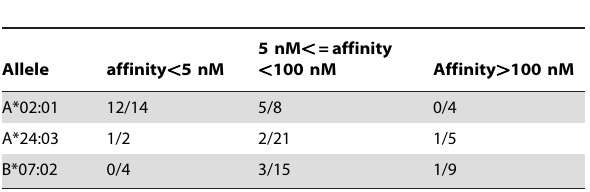
Table 4. Summary of ELISPOT results on peptide